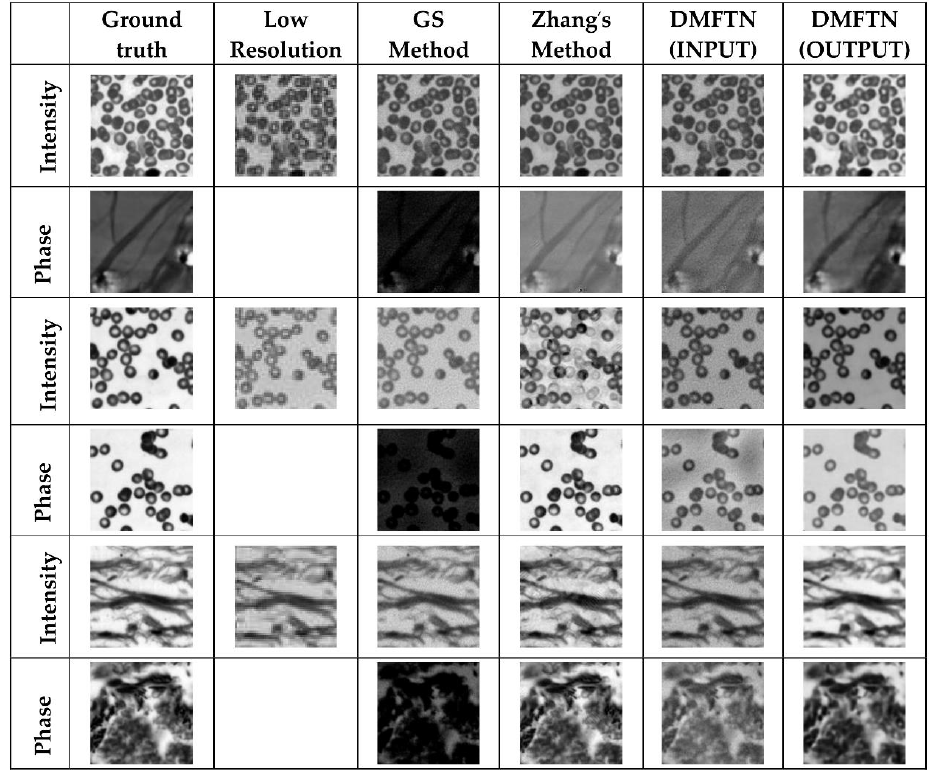
( b ) plot of training iterations vs. accuracy.